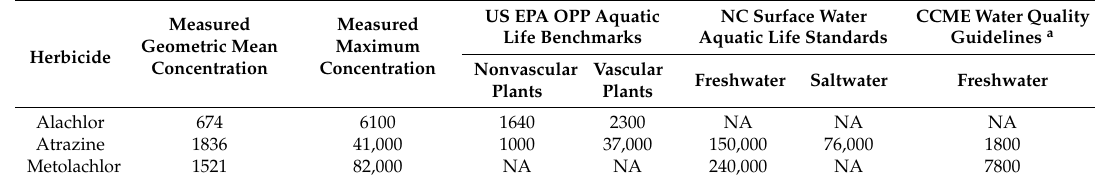
Table 1. Comparison of mean and maximum measured concentrations (ng/L) of alachlor, atrazine, and metolachlor measured at 26 sites in the Albemarle-Pamlico Estuarine System and their corresponding aquatic life protection benchmarks, standards, and guidelines from the U.S. Environmental